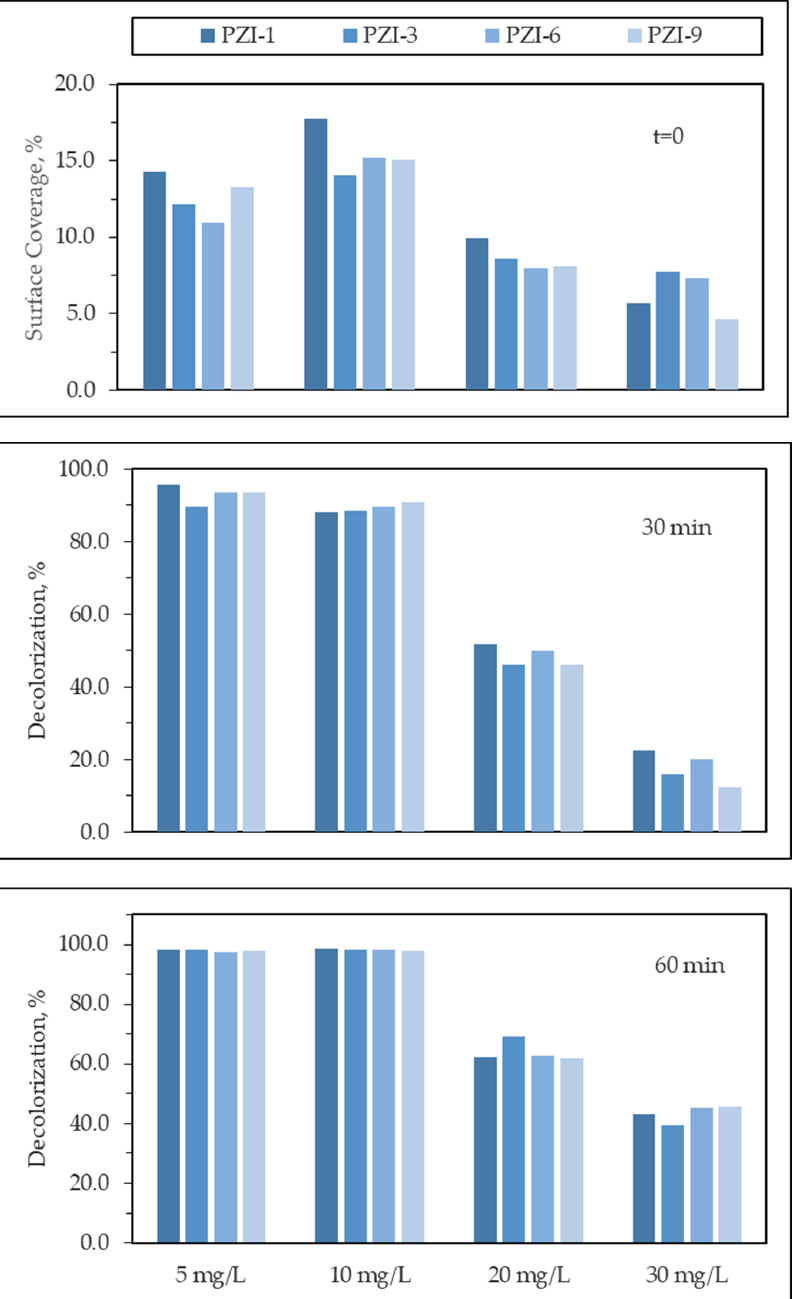
Figure 15. Photocatalytic degradation of MB upon use of PZI specimens: Initial MB concentration effect.